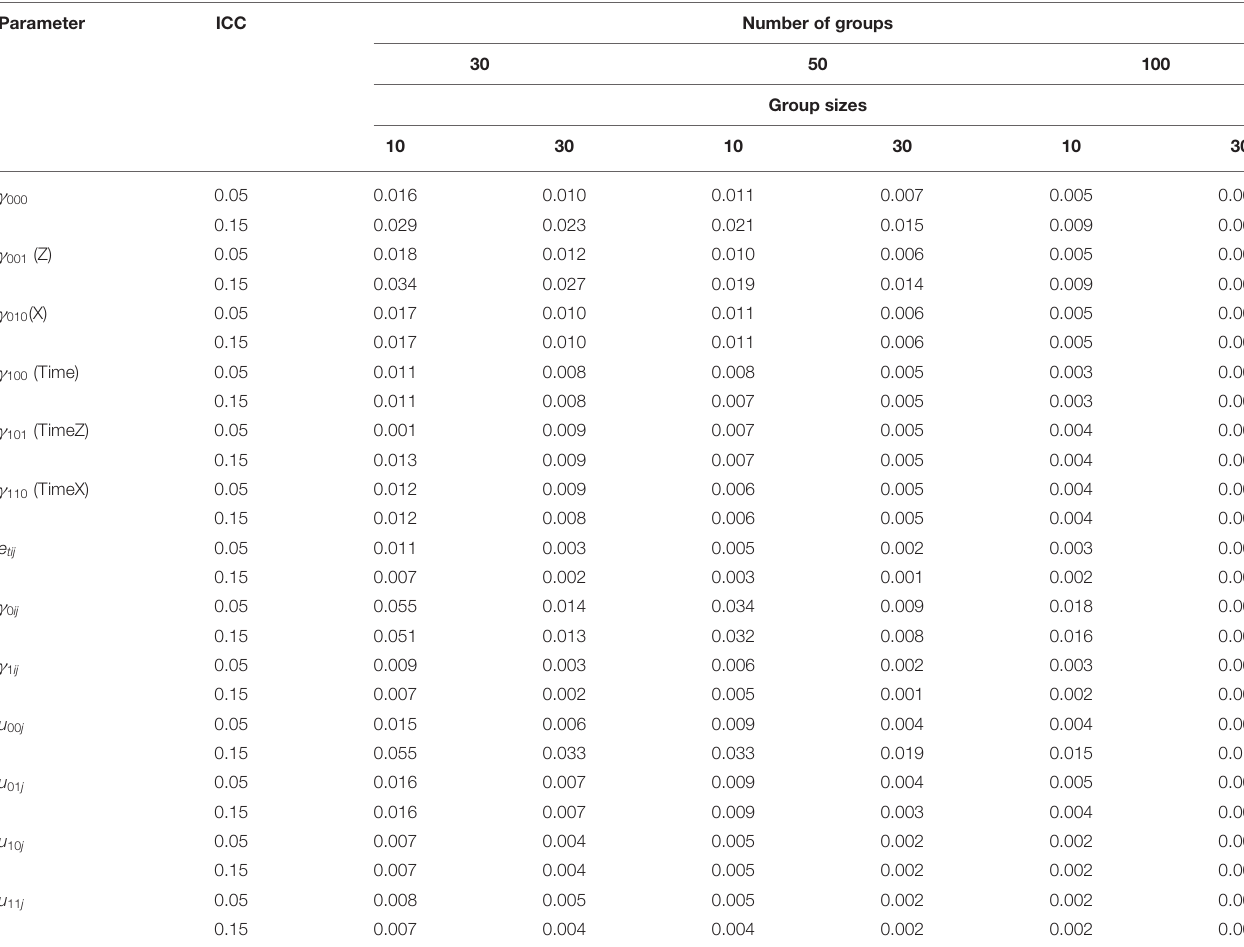
TABLE 1 | Mean Square Errors (MSEs) for fixed and random effect estimates.